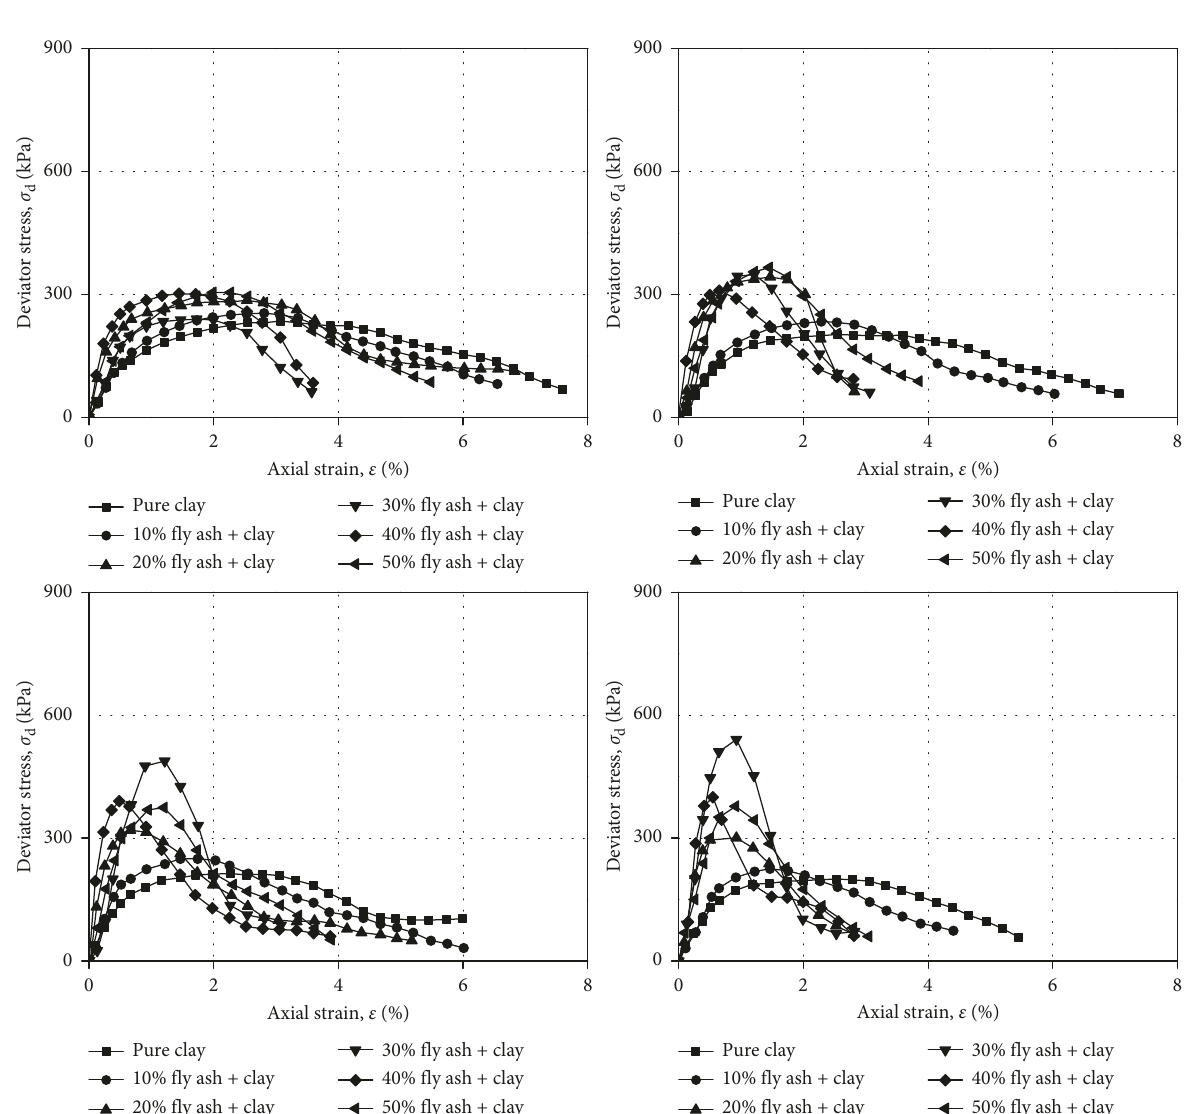
the maximum, but the residual strength after the peak is still lower than the specimen with the fiber content of 1.5%.